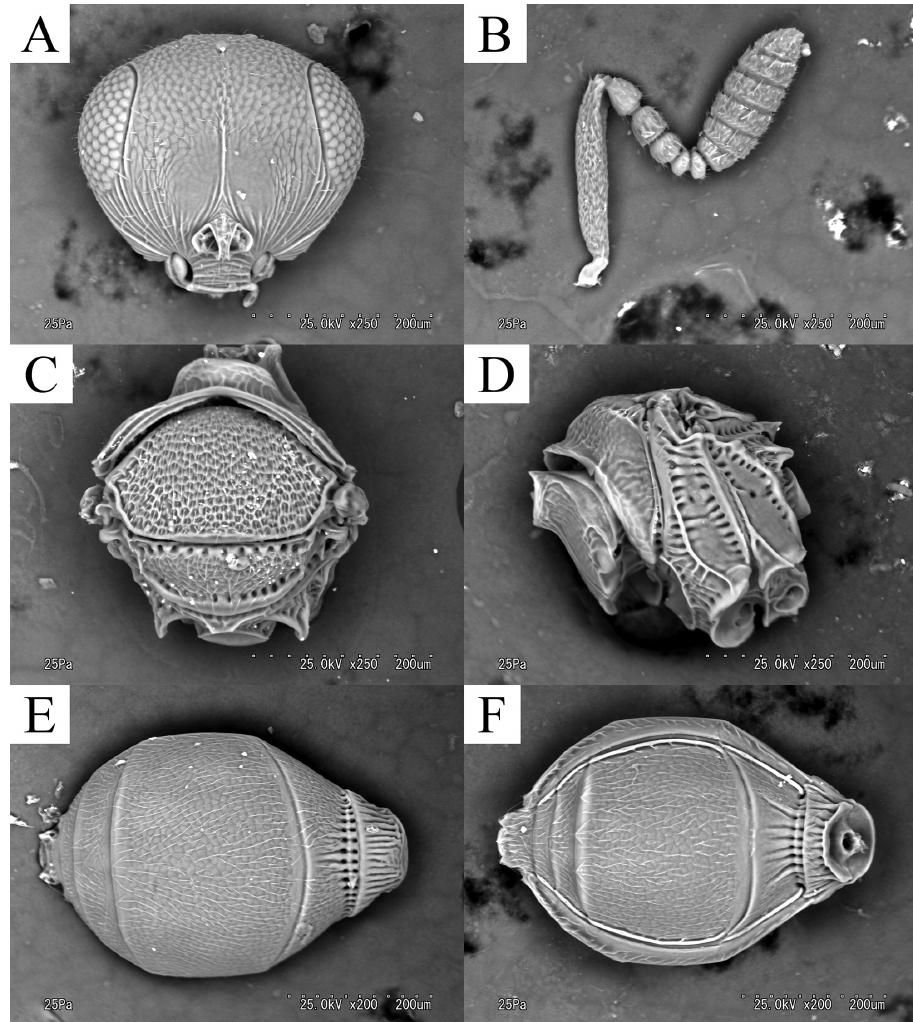
Figure 4. Trimorus coriaceus sp. n., female. A head, frontal view B Antennae C mesosoma, dorsal view D mesosoma, lateral view E metasoma, dorsal view F metasoma, ventral view.